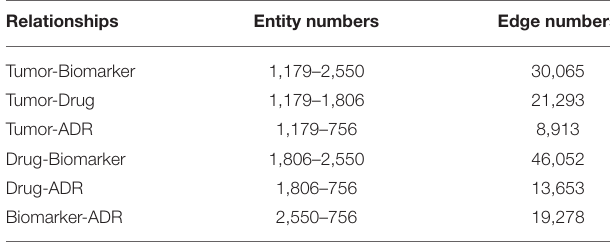
TABLE 2 | Numbers of entities and relationships in